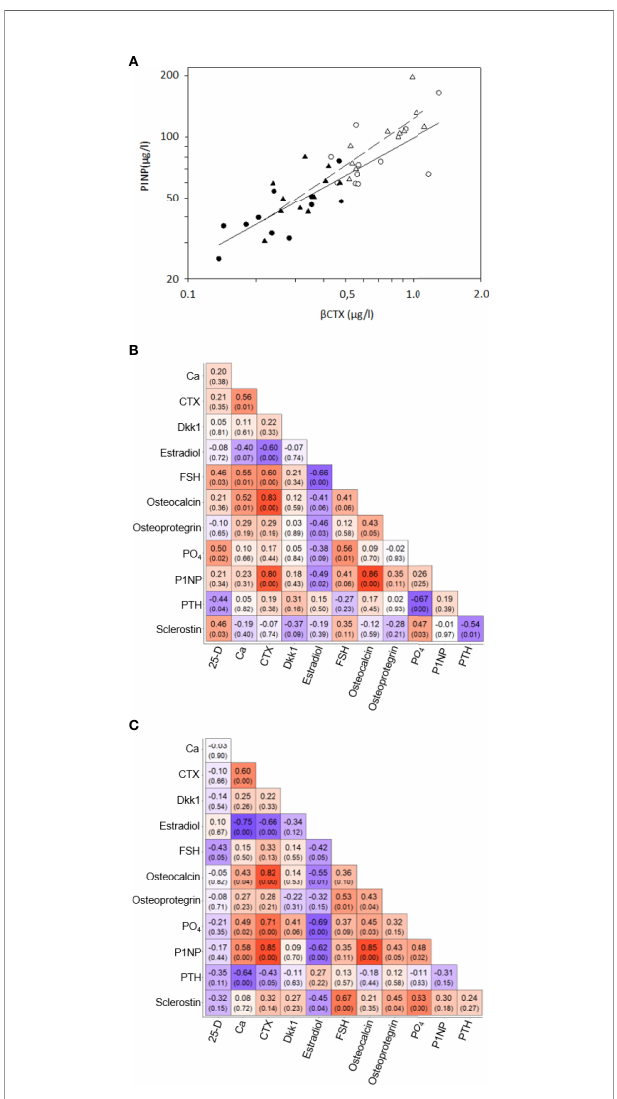
FIGURE 1 | Correlations of bone remodeling biomarkers – (A) Correlations between serum b CTX and P1NP in 11 women before oophorectomy, Group A ( (cid:129) ) and untreated after surgery, Group B (o) (solid line), and in 11 oophorectomized women untreated, Group C ( D ) and treated with estradiol, Group D ( ▲ ). (B) Correlation matrix of selected the bone remodelling biomarkers in the Group A and B. The matrix included Pearson ’ s correlation coef fi cients and p-value in the bracket below. The color indicates the strength and direction of the coef fi cient. (C) Correlation matrix of selected the bone remodelling biomarkers in the Group C and D. The matrix included Pearson ’ s correlation coef fi cients and p-value in the bracket below. The color indicates the strength and direction of the coef fi